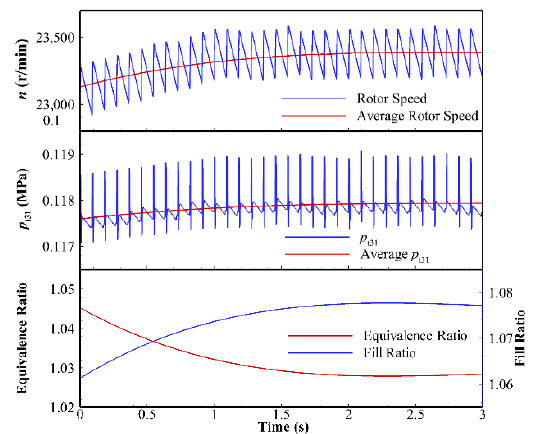
Figure 7. Dynamic response of PDTE with fuel changes.